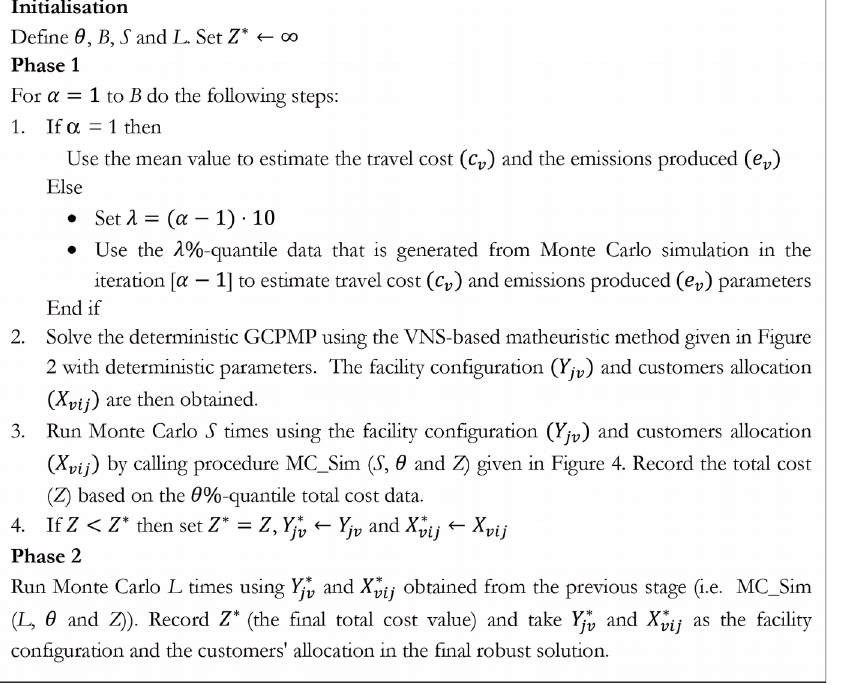
Figure 1. The proposed simulation-based optimisation for the stochastic